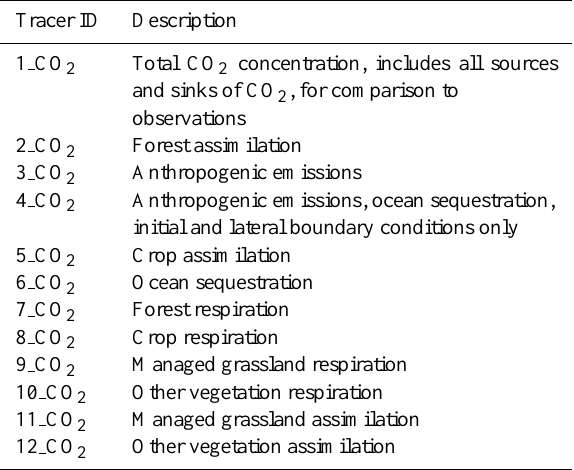
Table 1. Tracer pools and definitions used by